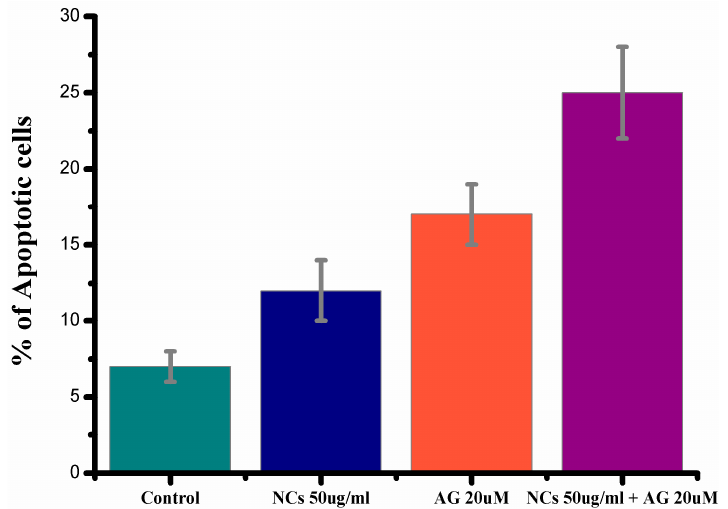
Figure 12. Annexin V-FITC/PI double staining analysis of apoptosis in A431 cells (24 h) and percentages of apoptosis in A431 cells.